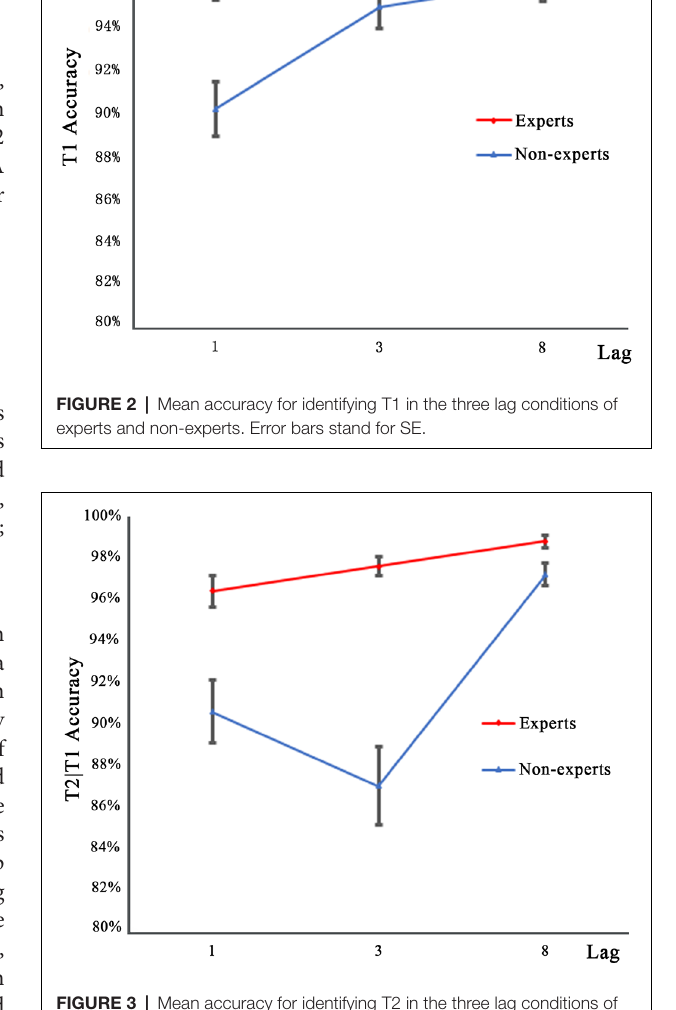
FIGURE 3 | Mean accuracy for identifying T2 in the three lag conditions of experts and non-experts when T1 was correctly identified. Error bars stand for